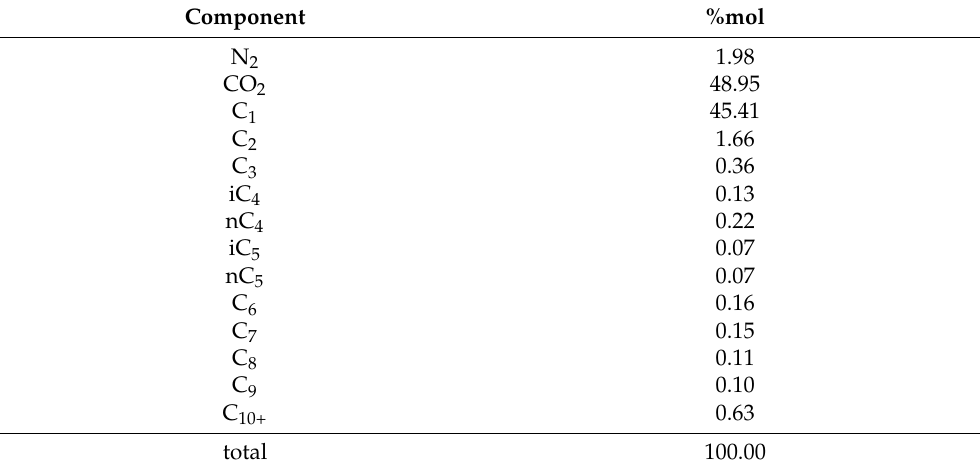
Table 1. Gas composition used in simulations.